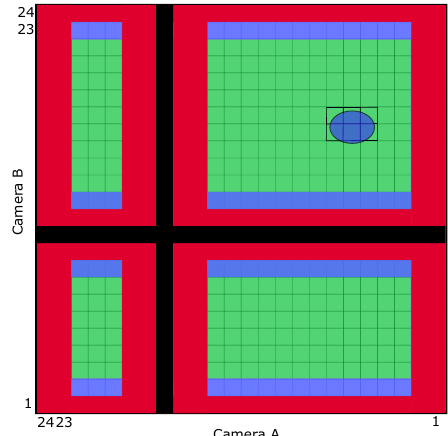
Figure 6. A cartoon of the sample area calculation of a 24 × 24 pixel domain for a 3 × 2 pixel drop detected during a time of partial instrumental insensitivity. Pixel coloring is the same as used in Figures 4 and 5. Additional area is removed from the sample area due to the presence of two simultaneous anomalies (shown in black). As before, the effective sample area for this drop would be calculated by adding the areas of all green pixels with half the areas of all blue